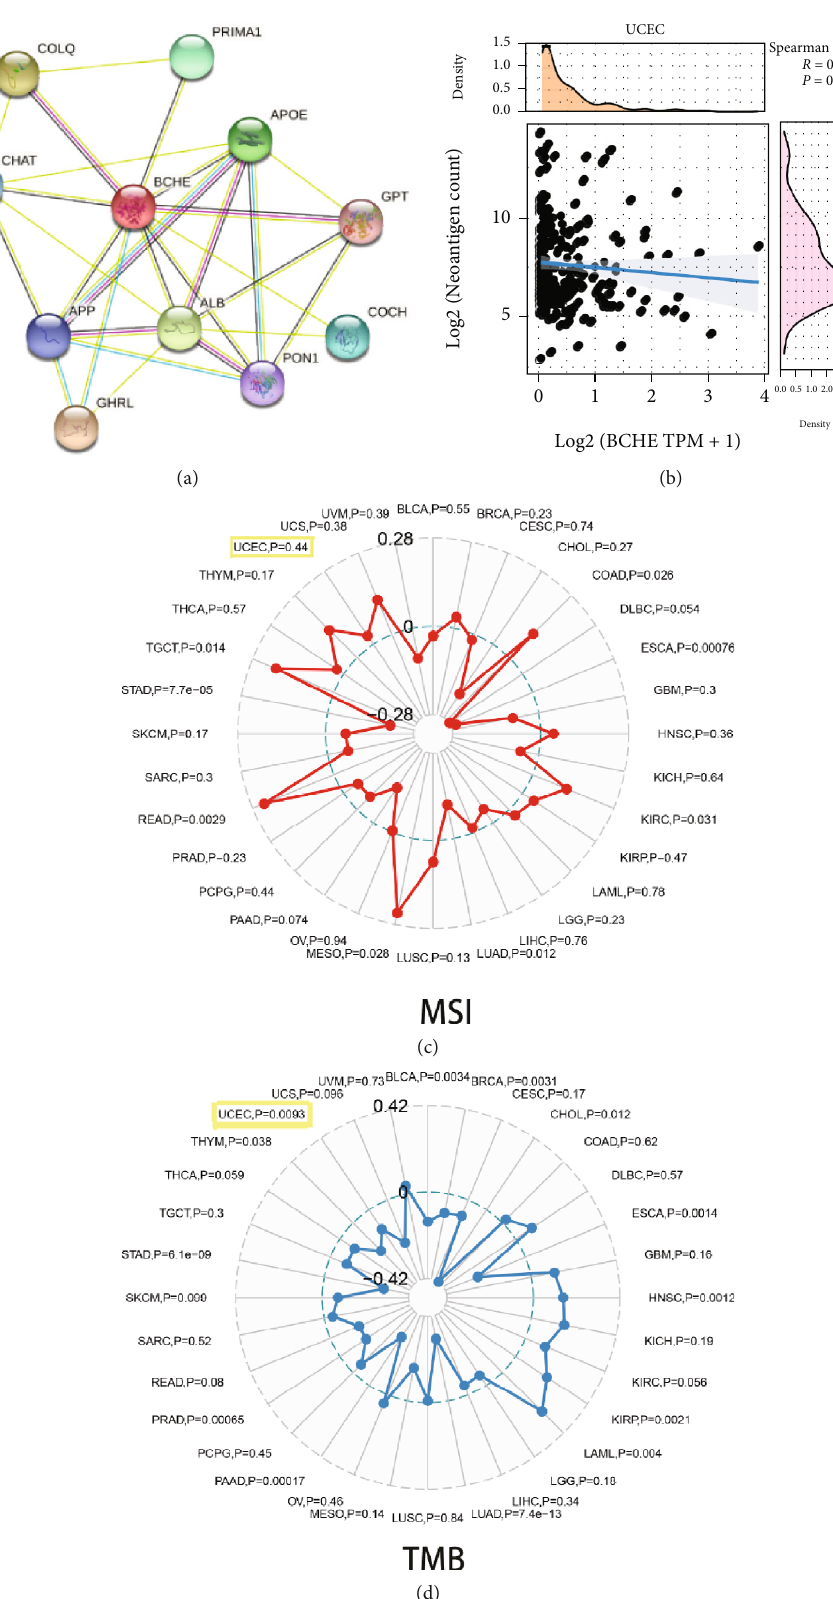
Figure 8: Relationships between BCHE and PPI, TNC, MSI, and TMB in EC. (a) PPI network. (b) Relationships between BCHE and TNC. (c) Relationships between BCHE and MSI. (d) Relationships between BCHE and